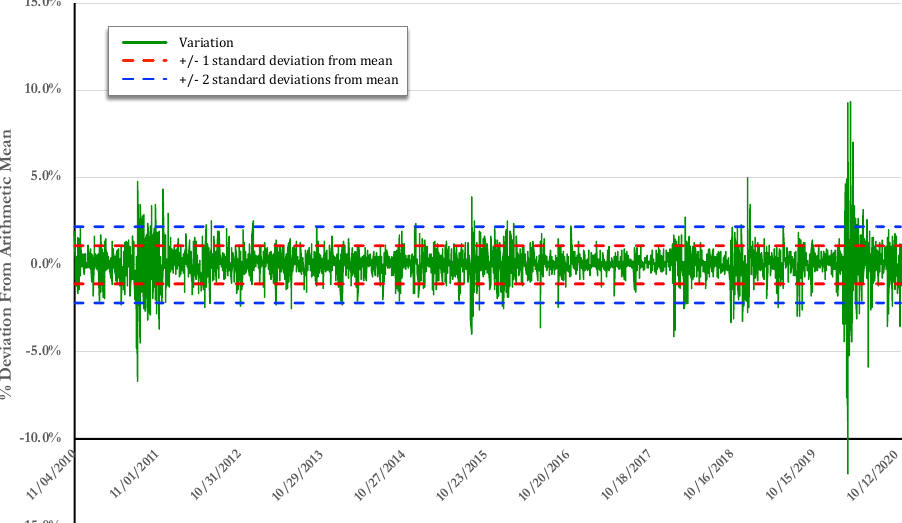
Figure 7. Daily % variation in S&P Index 2010–2020 (NASDQ